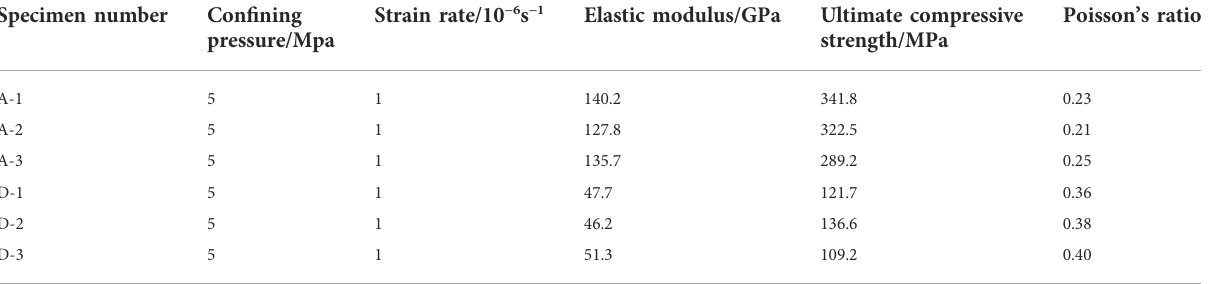
TABLE 2 Parametric results from the mechanical testing of the rock-forming minerals. Specimen number